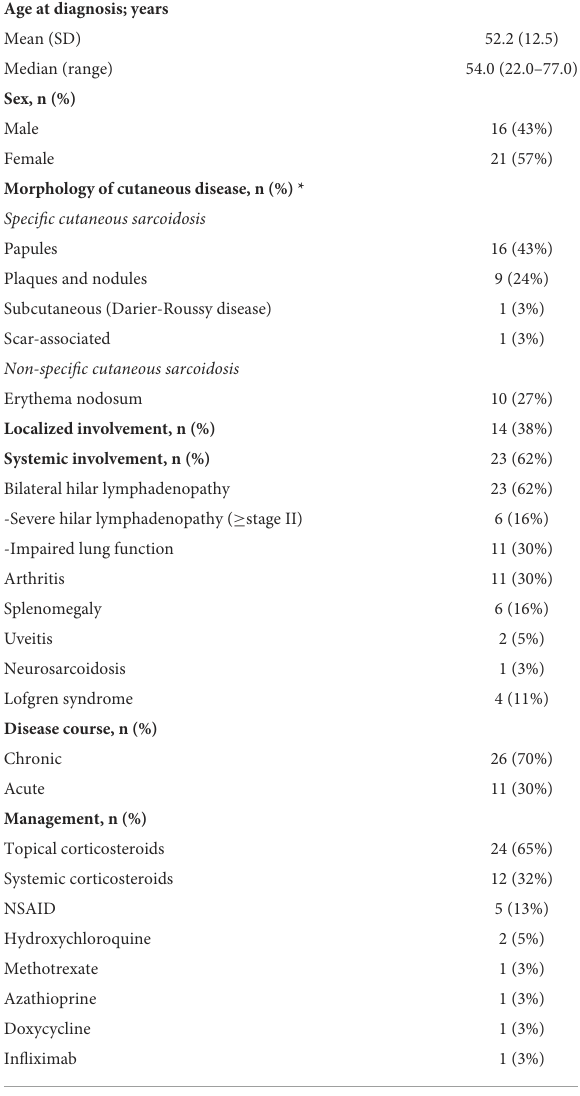
TABLE 1 Demographic and clinical characteristics of patients with cutaneous